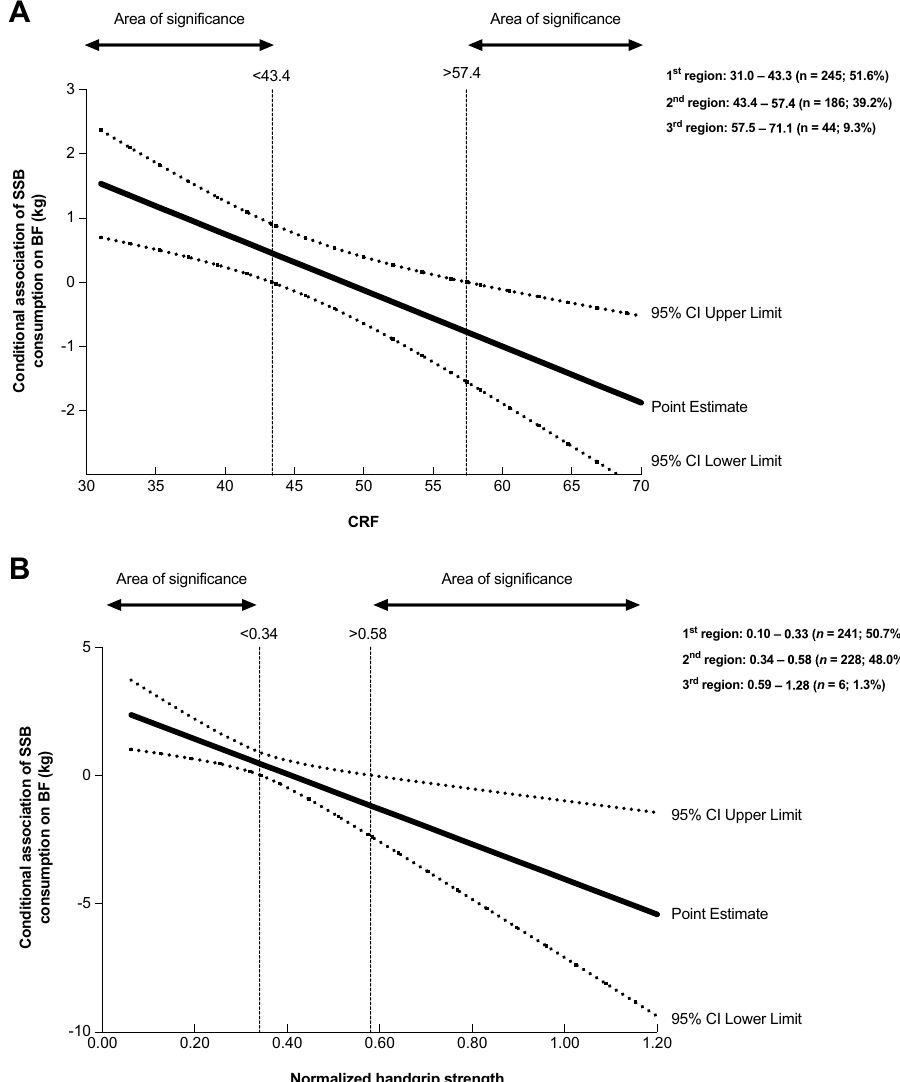
Figure 2. Moderating role of cardiorespiratory fitness and normalized handgrip strength on the association between sugar-sweetened beverage consumption and adiposity using the Johnson-Neyman procedure. Data are showed as a regression point estimate (beta unstandardized) and 95% confidence intervals. Adjusted for sex, age, socioeconomic status, somatic maturity, fat-free mass, fruit consumption, vegetables consumption, and sweets